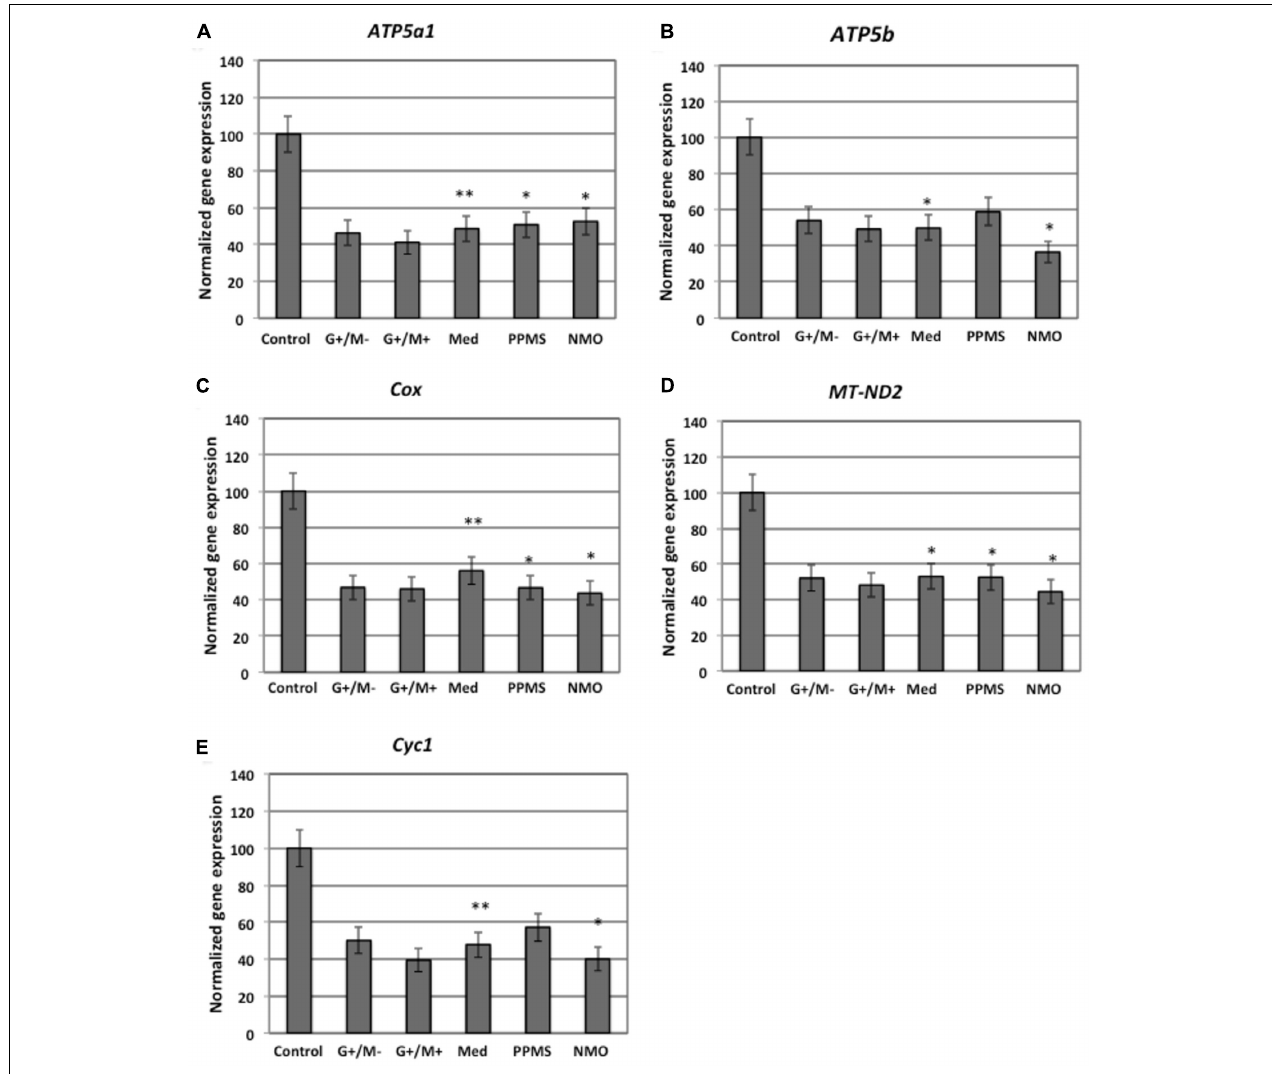
FIGURE 4 | Normalized expression of (A) ATP5a1 ; (B) ATP5b ; (C) Cox ; (D) MT-ND2 ; (E) Cyc1 genes involved in oxidative phosphorylation in OPCs treated with CSF of MS and NMO patients related to gene expression in OPCs treated with CSF of non-inflammatory neurological controls. OPCs: oligodendrocyte progenitor